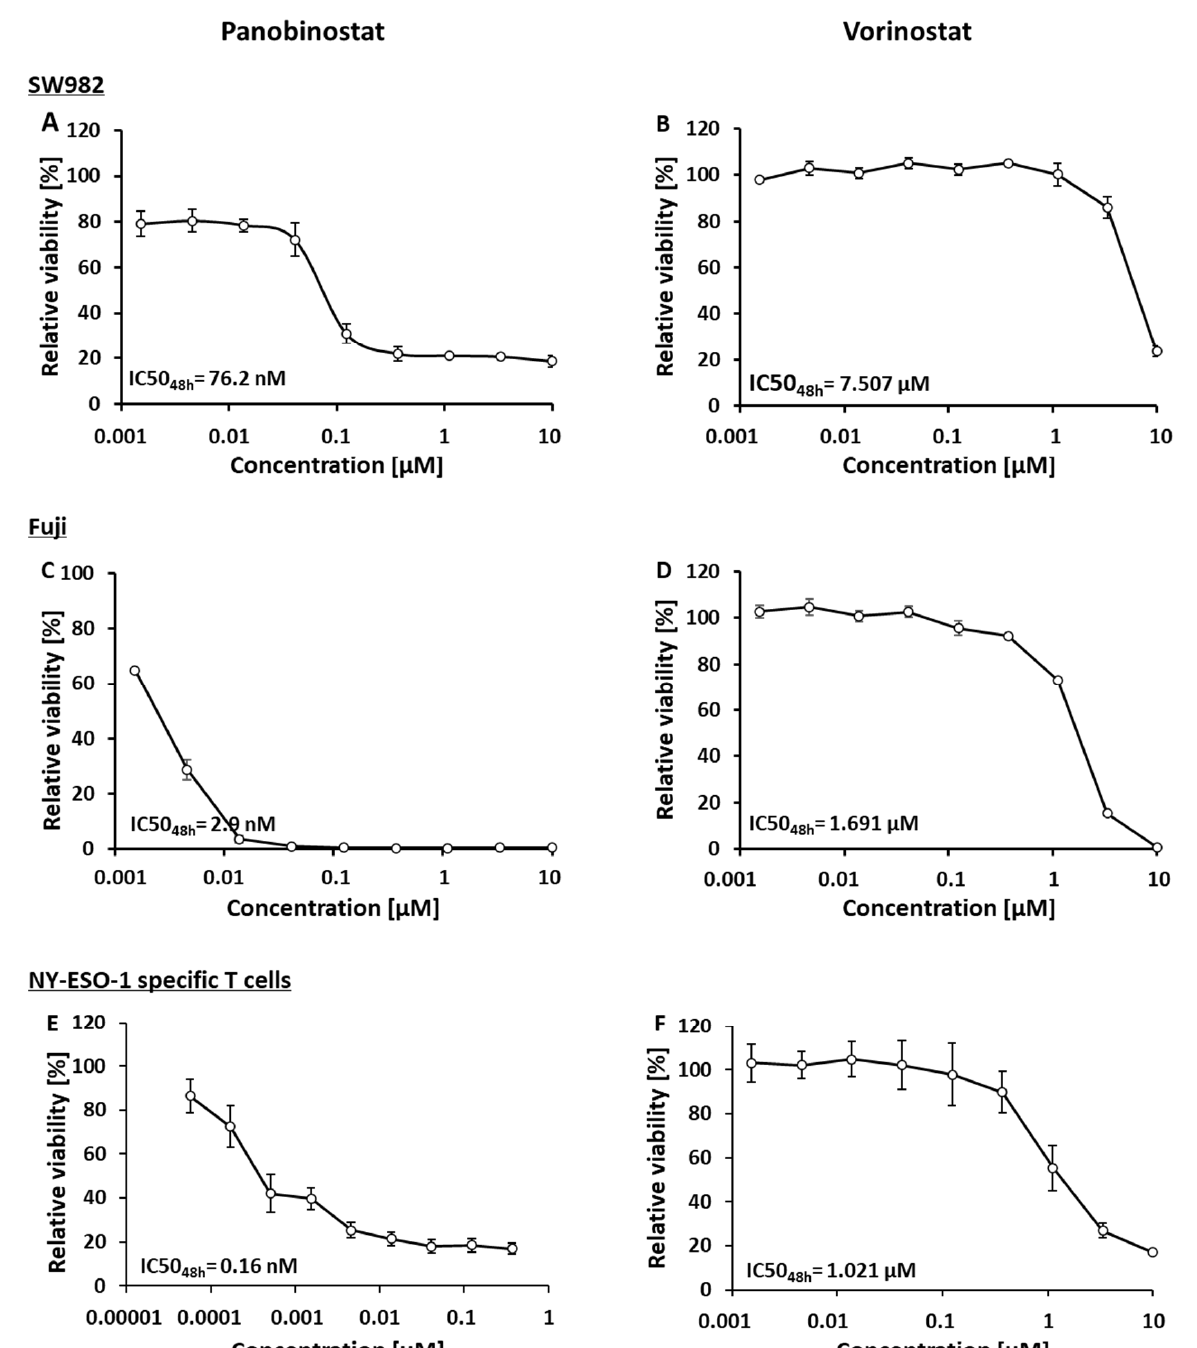
Figure 1. Cytotoxicity of the pan HDAC inhibitors panobinostat and vorinostat on the STS cell lines SW982 ( A , B ) and Fuji ( C , D ) and NY-ESO-1-specific T cells ( E , F ). Pronounced up-regulation of NY-ESO-1 at mRNA level was observed in SW982 cells after a 48h treatment with 0.005 µ M panobinostat (panobinostat/DMSO: 1.96 ± 0.13 fold, p < 0.001, Figure 2A). Additionally, 0.5 µ M vorinostat only showed a trend towards in- creased NY-ESO-1 expression at the mRNA level (vorinostat/DMSO: 1.37 ± 0.11 fold, p = 0.06, Figure 2A). No induction of NY-ESO-1 mRNA by HDACi was detected in NY- ESO-1-negative Fuji cells (data not